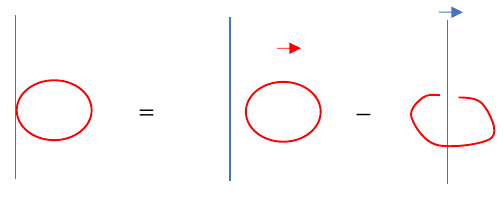
Figure 3 . Linking in the bulk and intersection on the